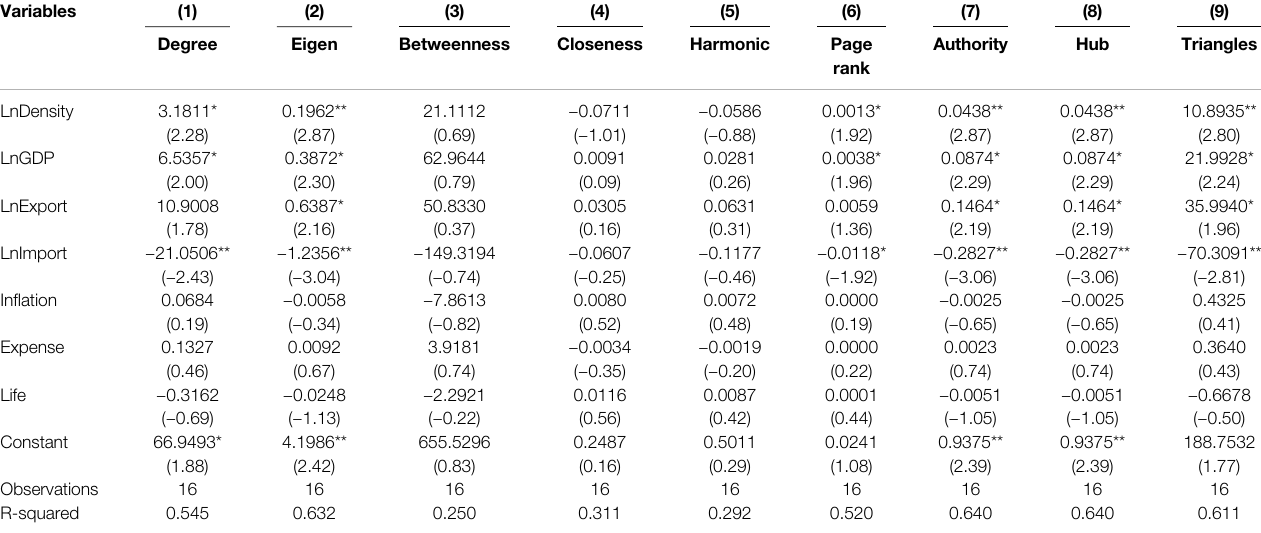
TABLE 3 | Determinants of connectedness: Asia. Variables